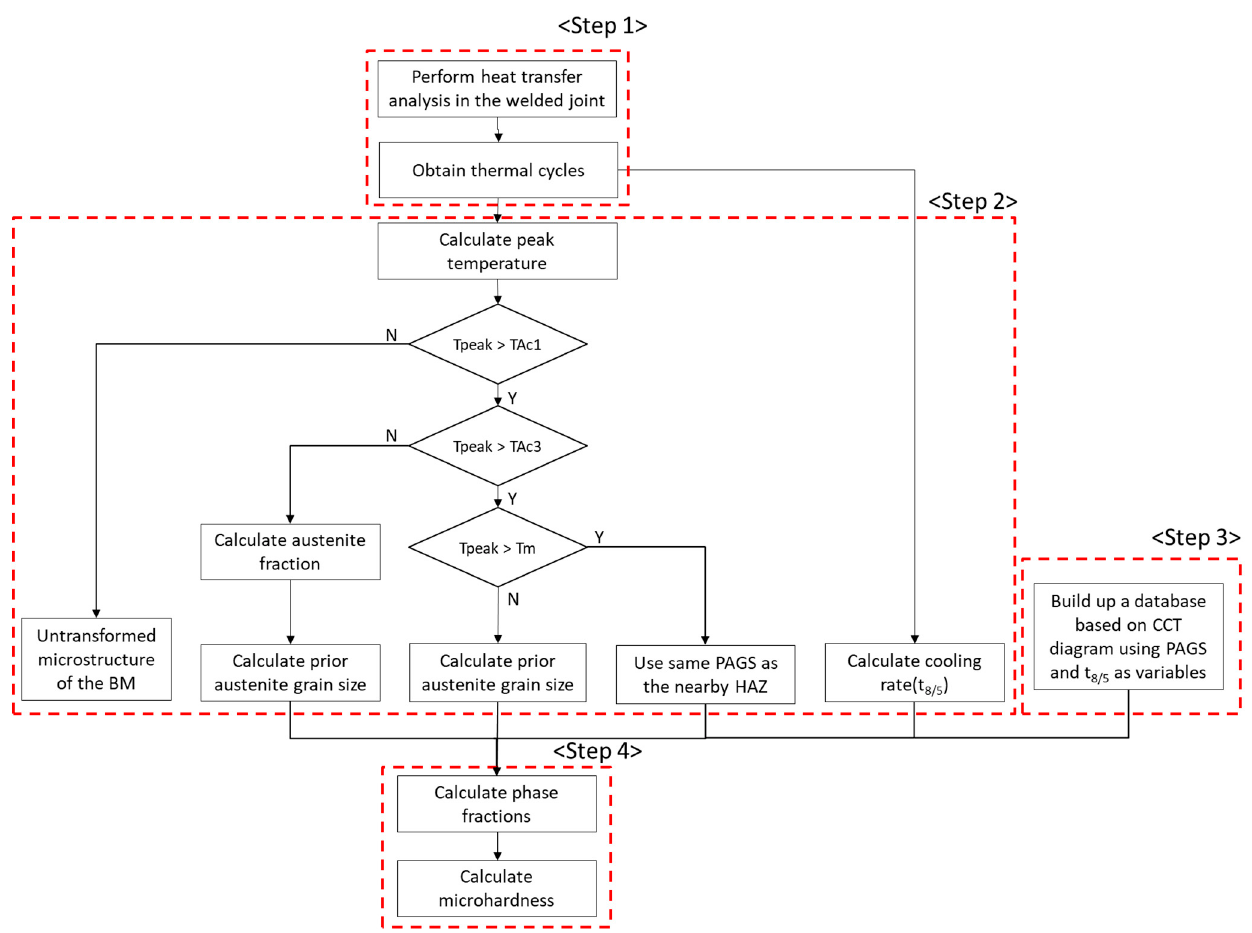
Figure 1. Flowchart for predicting the phase fraction and microhardness in welded joint.